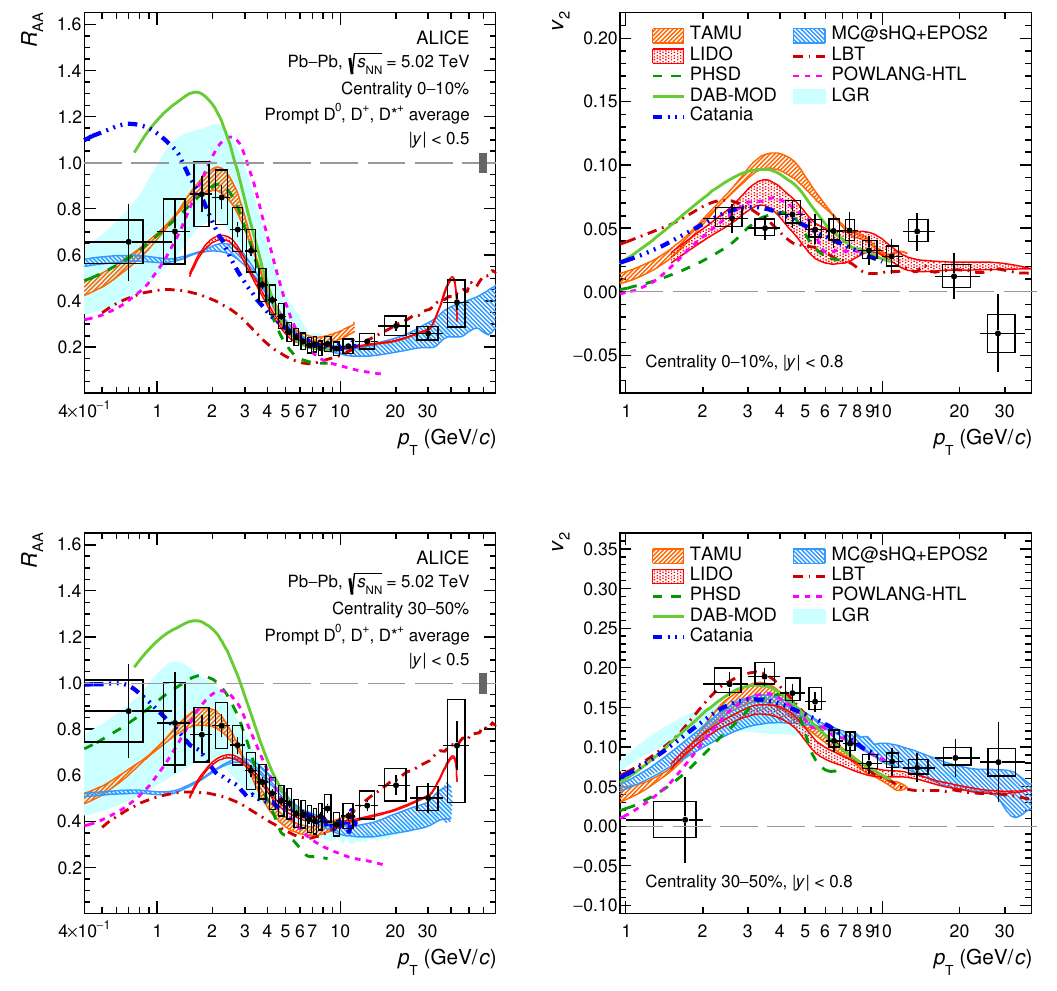
Figure 11 . Average R AA (left) and elliptic flow v 2 [36] (right) of prompt D 0 , D + , and D ∗ + mesons in the 0–10% (top) and 30–50% (bottom) centrality classes compared with predictions of